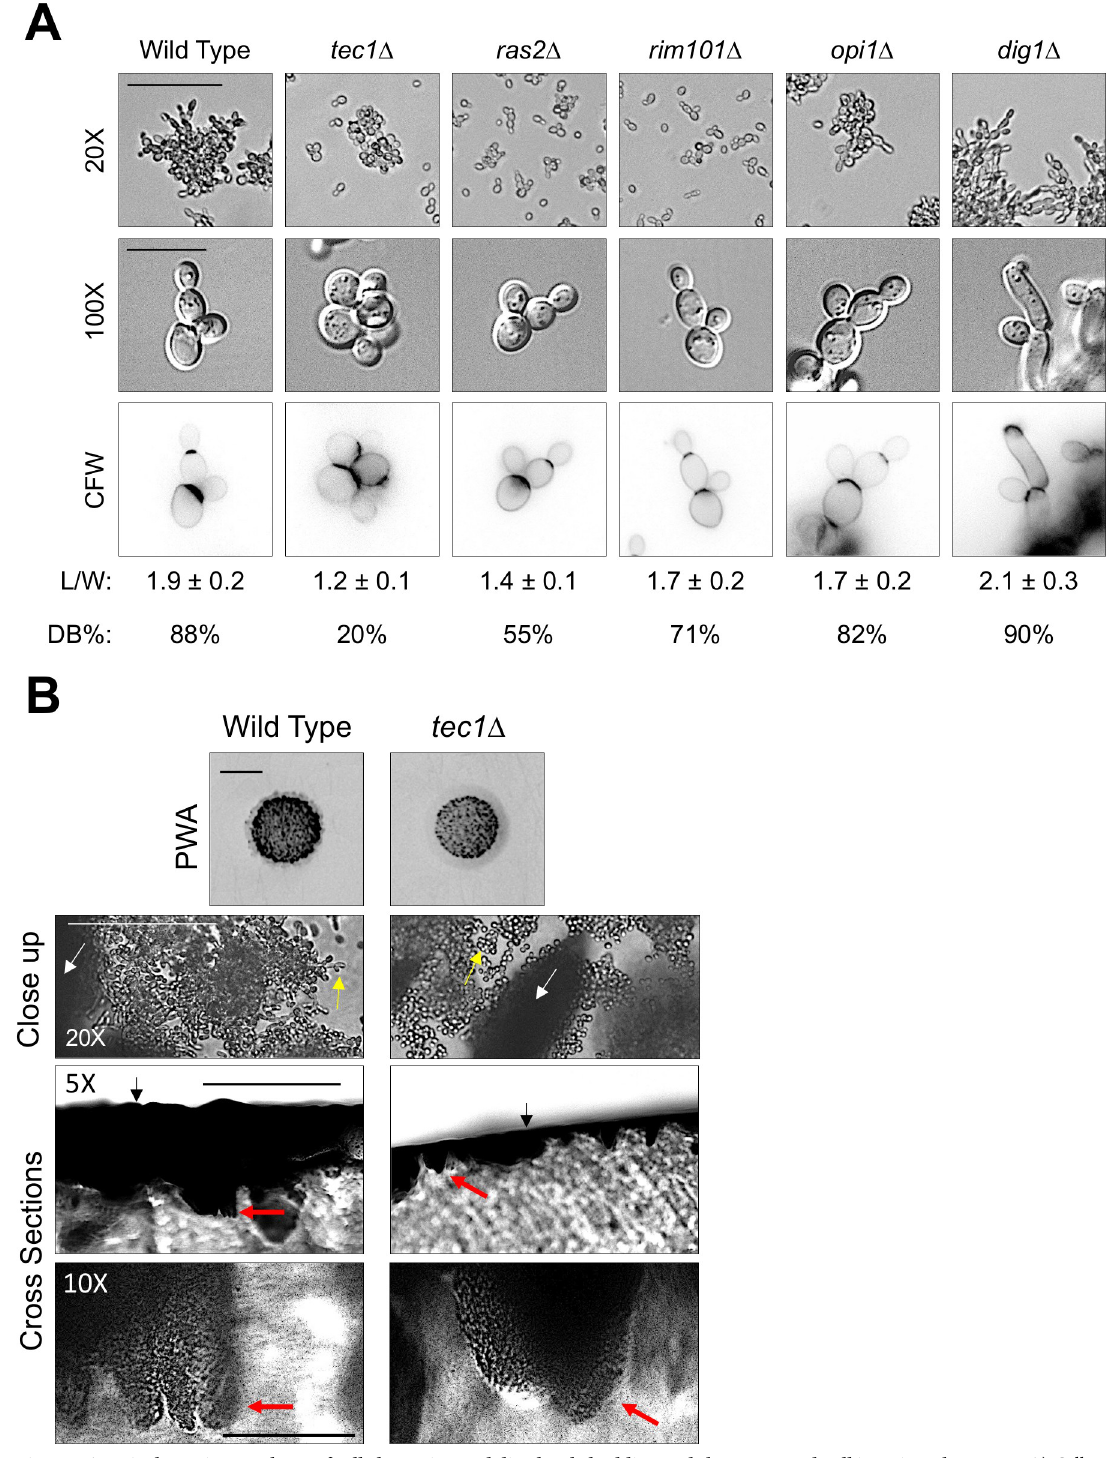
Fig 6. MAPK is the major regulator of cell elongation and distal-pole budding and shows a round-cell invasion phenotype. A) Cell morphology analysis. Cells were compared by microscopy at 20X and 100X magnification after growth in YPGAL for 21 h, 20X bar, 50 μ m, 100X Bar, 10 μ m. CFW, calcofluor white stained images of bud scars. L/W, quantification of cell length-to-width ratio. DB%, percentage of cells with distal-budding pattern. B) Cross section analysis. PWA, inverted image of invasive scar, bar, 0.5 cm. Close up, 20X magnification image by microscopy of invasive scar, bar, 100 μ m. White arrows, invading cells below the agar surface (out of